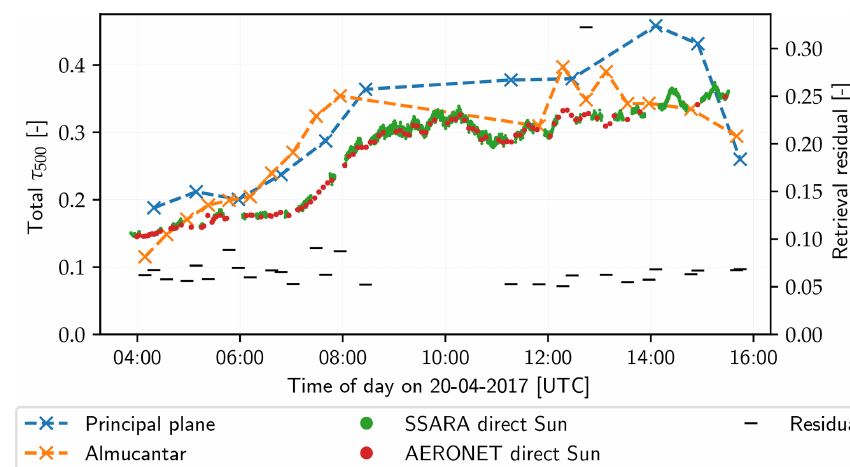
Figure 15. Same as Fig. 12 but for 20 April 2017.